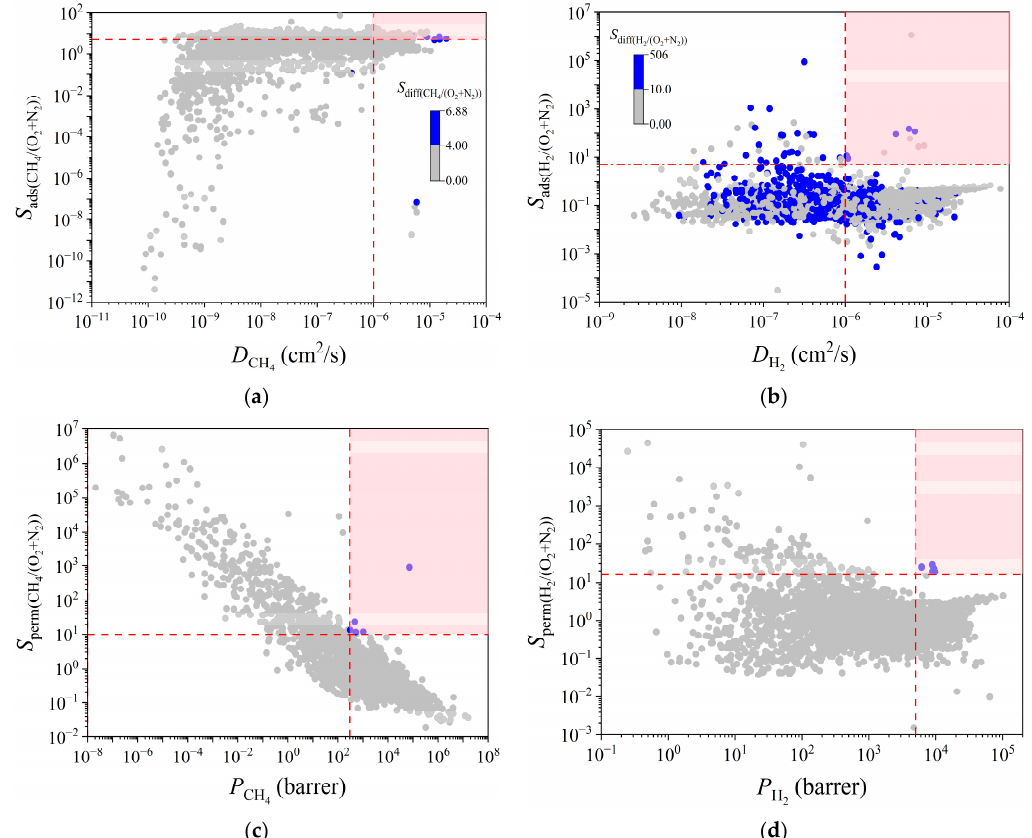
Figure 5. ( a , b ) Selectivity S ads vs. diffusion coefficient D and ( c , d ) permeation selectivity S perm vs. permeability P for CH 4 /O 2 + N 2 and H 2 /O 2 + N 2 in 6013 CoRE-MOFs. The color coding represents the diffusion selectivity S diff